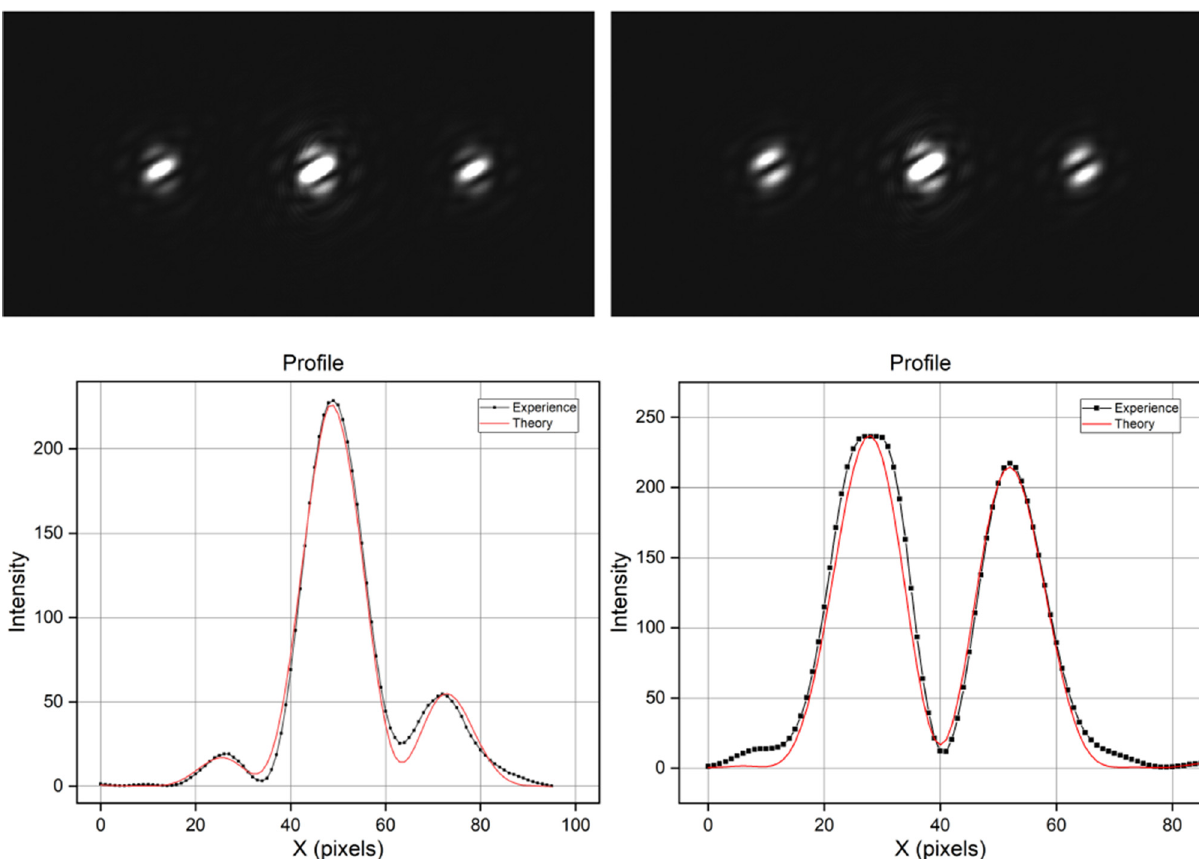
Fig. 5. On the top, orders − 1, 0 and +1 diffracted by the DMD with two gratings displayed. On the left, the dephasing is ∆ φ = π/ 2 , on the right ∆ φ = π . The plots below correspond to the intensity profile of the first order, perpendicularly to the fringes, for the two corresponding dephasings. Here G = 131 . 5 µ m.